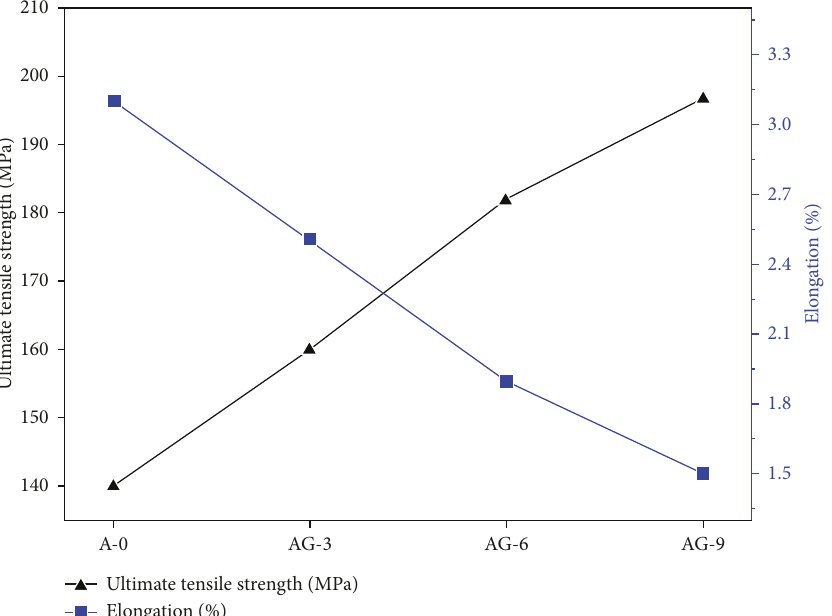
Figure 5: Variation of tensile strength and elongation (%) of AA7075 alloy and cast composites.